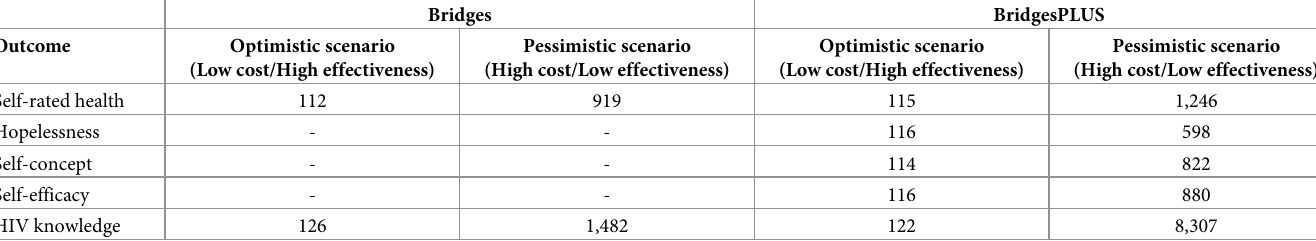
Table 4. Sensitivity analysis of incremental cost-effectiveness ratios (ICERs) (in 2012 US